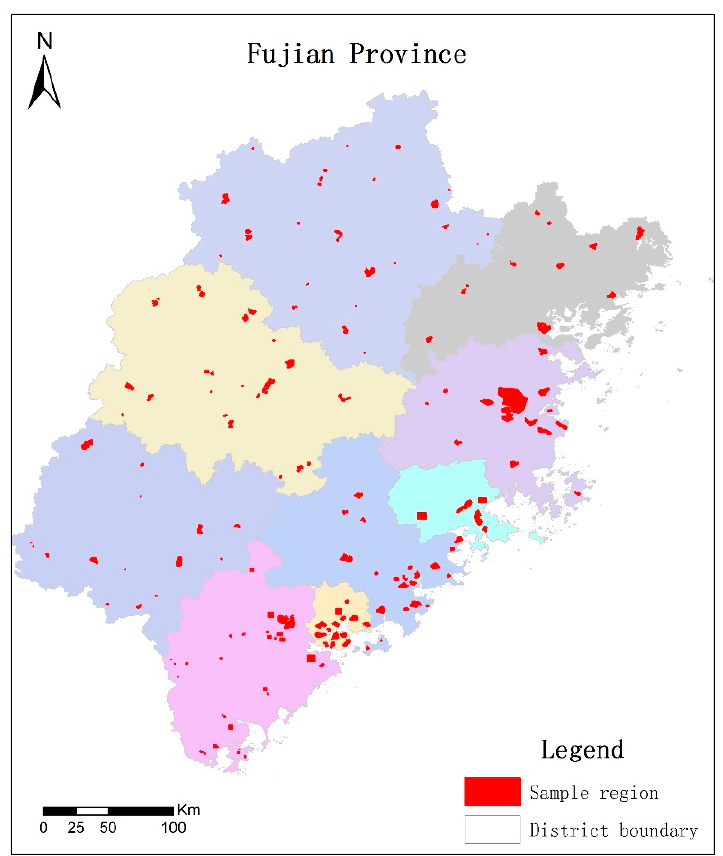
Figure 6. Typical regions of building samples in Fujian province of China. Images from Fujian province were collected and annotated manually to form the building outline dataset.